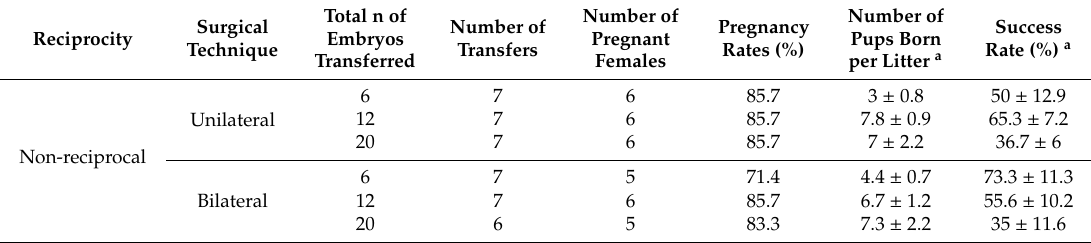
Table 4. B6129F1 transfer groups and